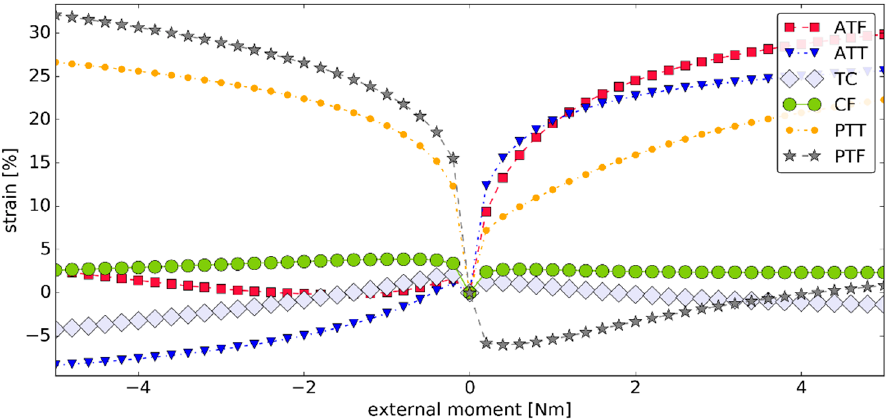
Figure 8. The strains within the ligaments as seen in the sagittal plane versus the external moment M ext in simulation #2 (negative [positive] strain corresponded to an inactive [active]